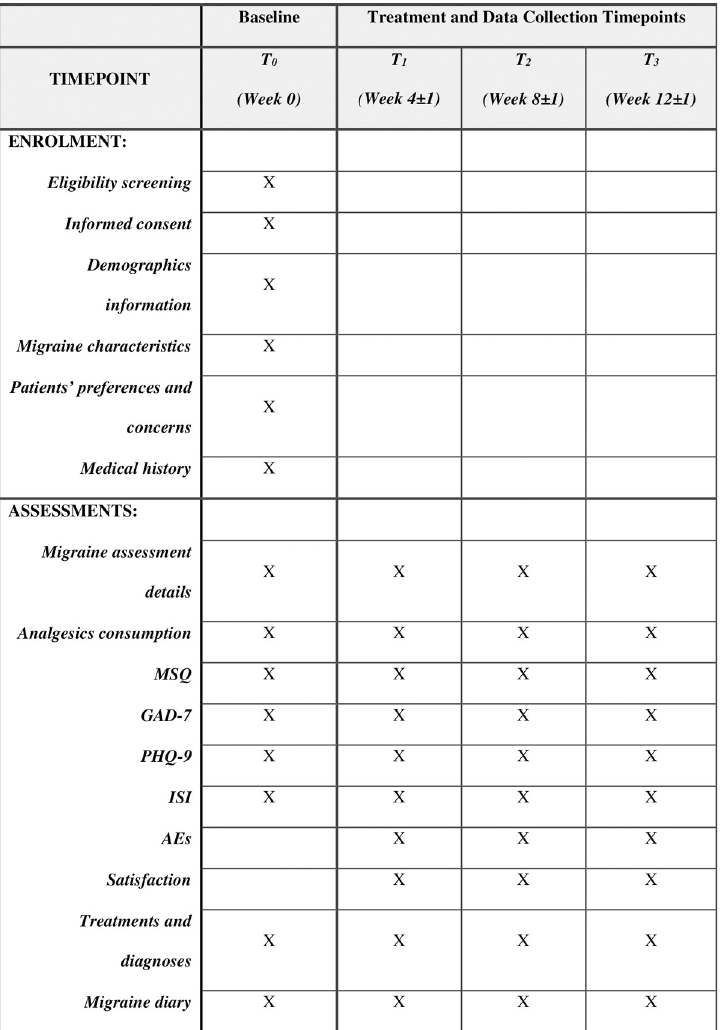
Fig 1. SPIRIT schedule of enrolment and assessments. AEs: Adverse Events, GAD-7: Generalised Anxiety Disorder 7-item Scale, ISI: Insomnia Severity Index Scale, MSQ: Migraine Specific Quality of Life Questionnaire, PHQ-9: Patient Health Questionnaire-9, T 0 : Timepoint 0, T 1 : Timepoint 1, T 2 : Timepoint 2, T 3 : Timepoint 3.